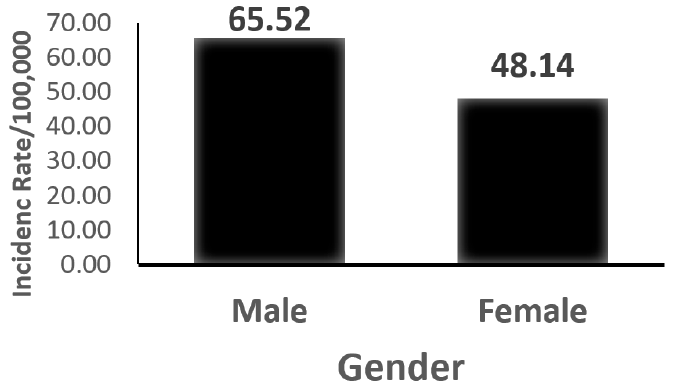
Figure 2. Minimal incidence rate of hospitalized first-time stroke (per 100,000 people) by gender.